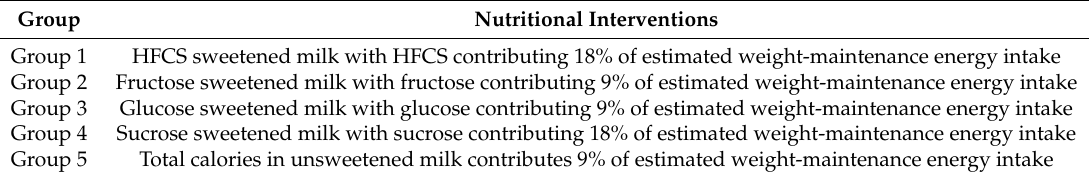
Table 1. Study design